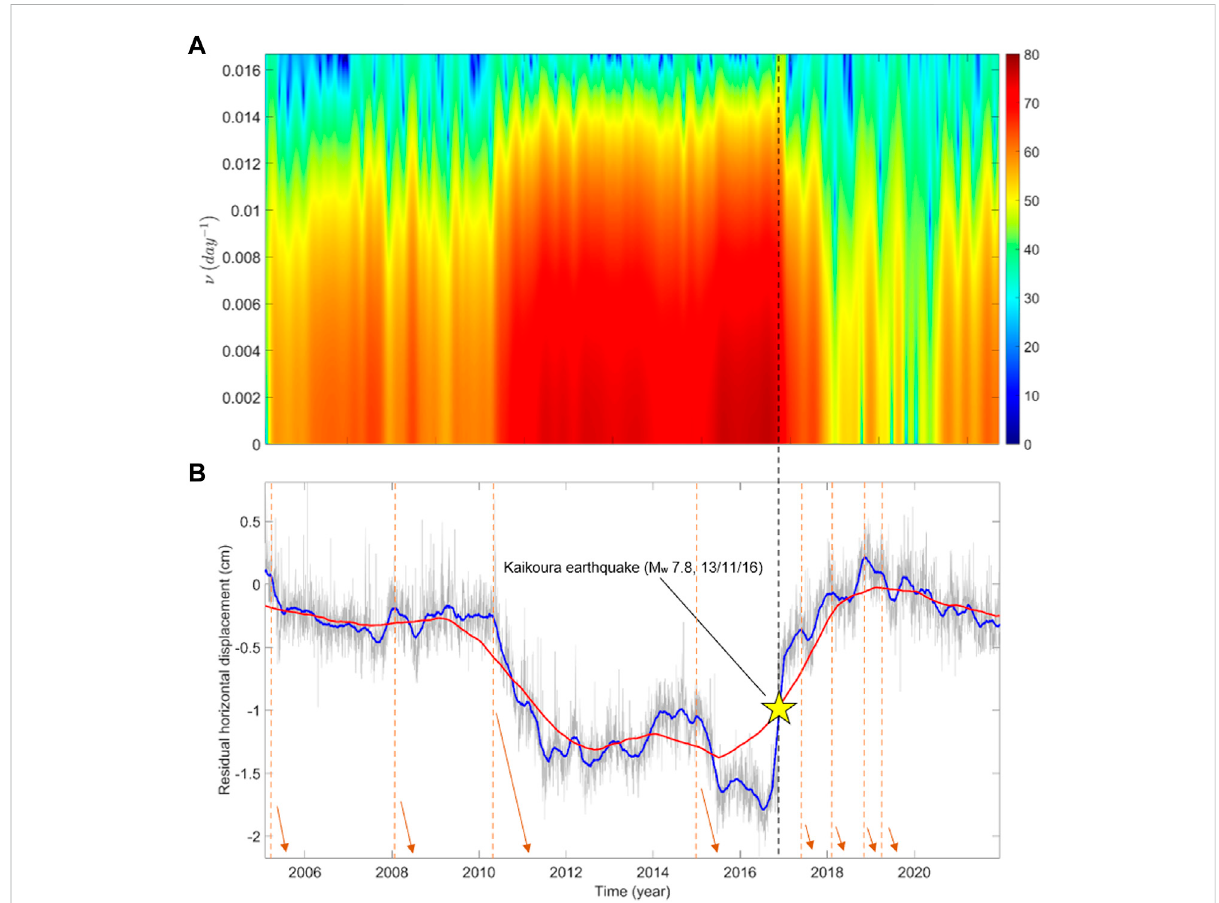
FIGURE 10 (A) Spectrogram of GNSS time series of VGMT. Large low frequencies have been recorded from 2011, after a one-year-long slow slip, to 2016, when the Kaikoura event occurred. VGMT is 424.3 km far from the epicenter of M w 7.8, 13/11/2016 earthquake (NLG). (B) Residual horizontal displacement of VGMT, showing both the movements due to SSEs occurred in the Manawatu region in 2005, 2008, 2010, 2011, 2012, 2013, 2015, and 2019, whose starting timing is marked by orange vertical dashed lines, and the effect of the slip propagated remotely from the Kaikoura region, where the large earthquake hit in November